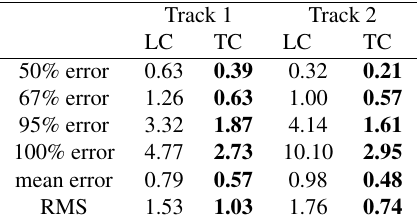
Table 2: The error statistics of LC and TC navigation solutions in kinematic phases (Unit: